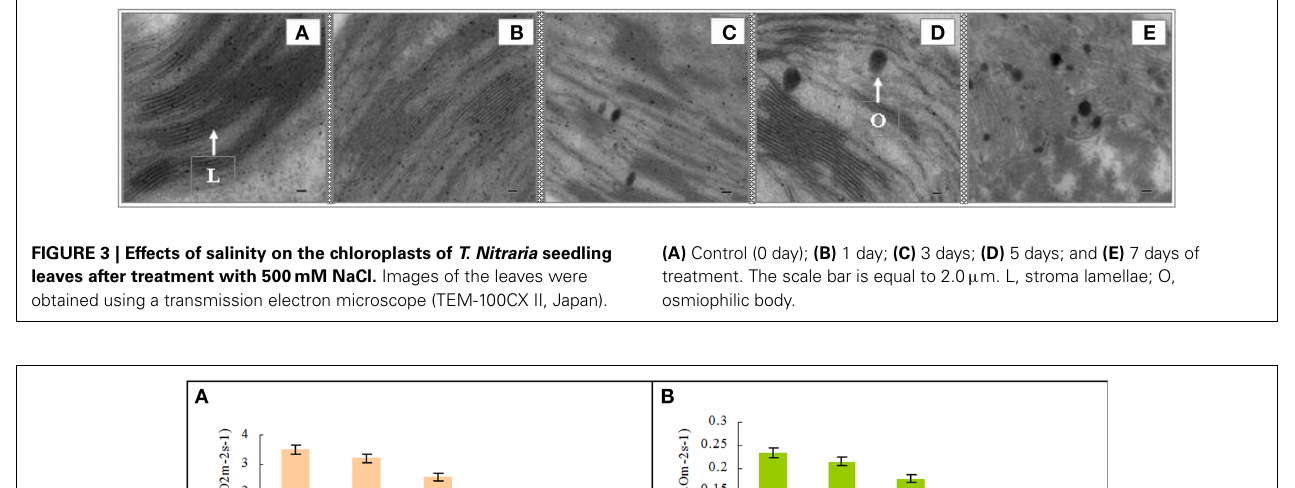
n = 6 for all groups. The bars represent the SE. Bars with the same letter are not significantly different ( P < 0 .